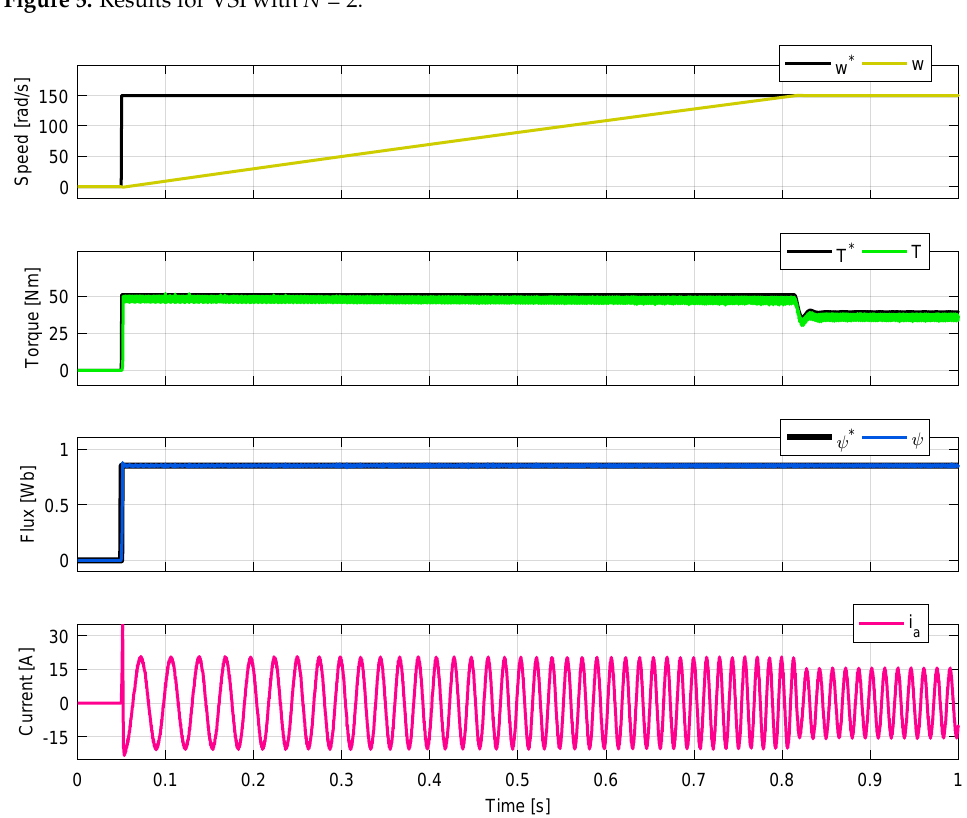
Figure 5. Results for VSI with N = 2.